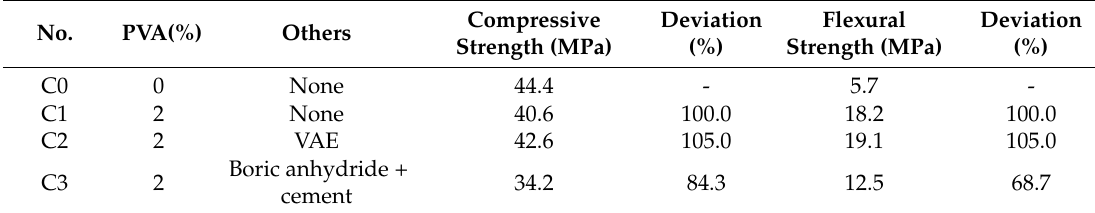
Table 8. Compressive and flexural strength of 28d